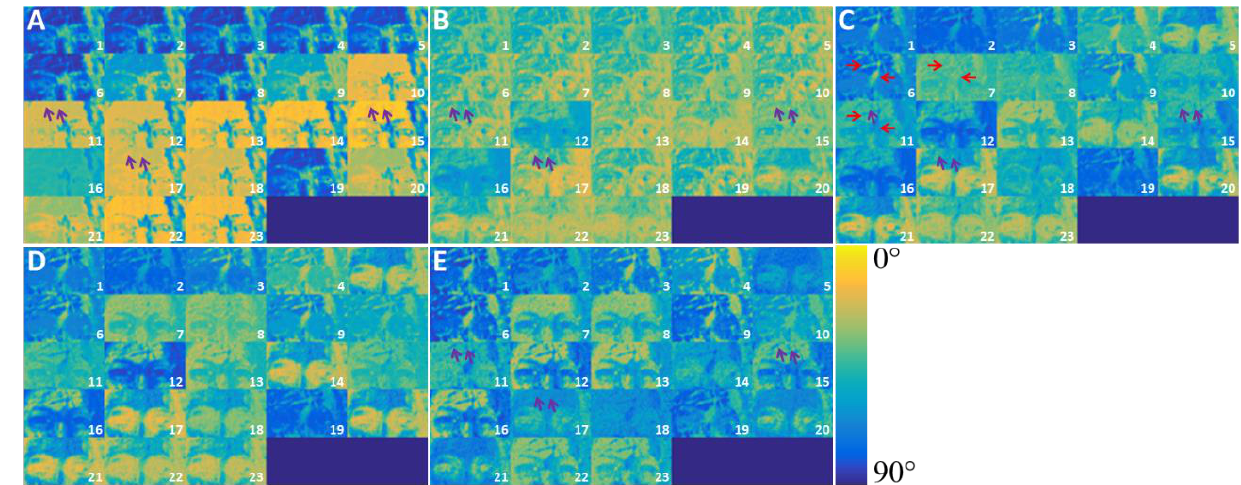
Figure 7. The sets of similarity maps, [ A ] , for the isolated test spectra of the Gable of San Diego obtained following the incidence criterion. The numbers within the panels refer to Table 2, the letters to Table 6. The color bar illustrates the level of similarity (in terms of the angle between vectors). ( A ) shows [ A ] , the set of similarity maps obtained without manipulating the spectra. ( B ) shows [ A ] , obtained after that the channels around 12.6 and 10.5 keV have been suppressed. ( C ) shows [ A ] , the k α and the k β series of Ca at 3.7 and 4 keV have been removed. ( D ) shows [ A ] , the contributions 2 k 4 k 7 minor or equal to 3.3 keV have been all removed. ( E ) shows [ A ] , the similarity maps obtained after the removal of the k 8 6.4 keV k α series of Iron. Purple arrows in ( A – C and E ) and red arrows in ( C ) highlight the areas of interest discussed in the text (in ( C ) one of the purple arrows on point 11 has not been reported in order to not interfere with the details highlighted by the red